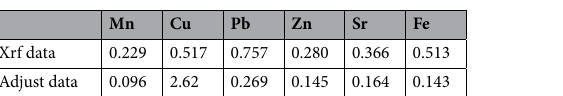
Table 6. Relative error of different heavy